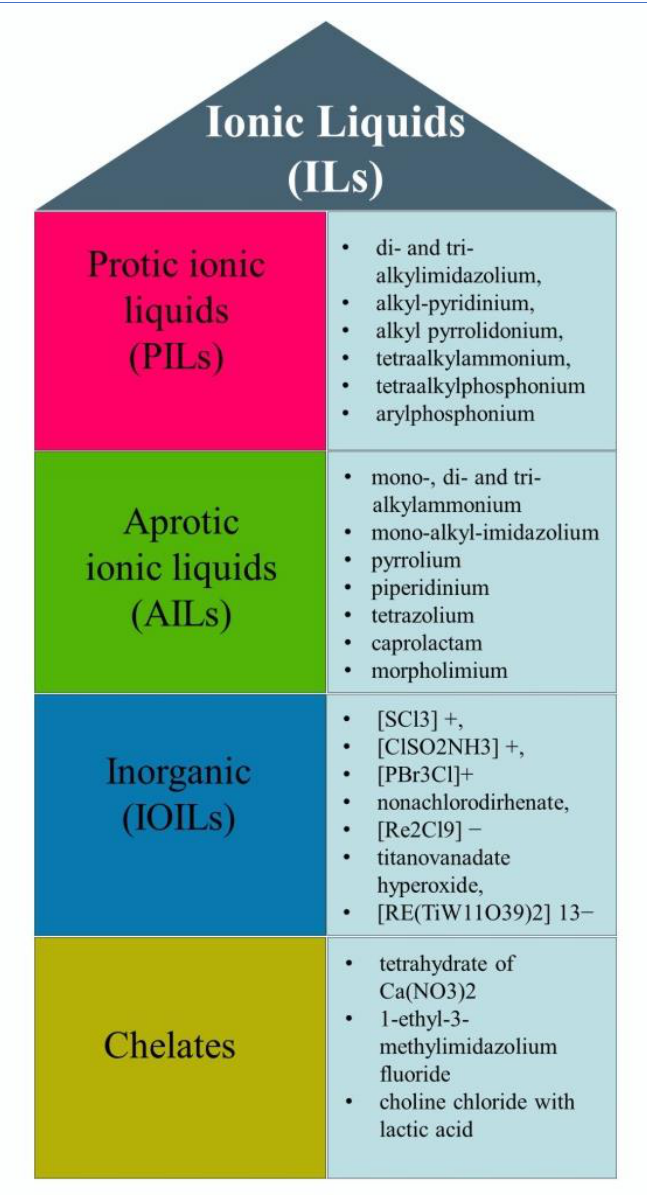
Figure 4. IL types and their classifications.